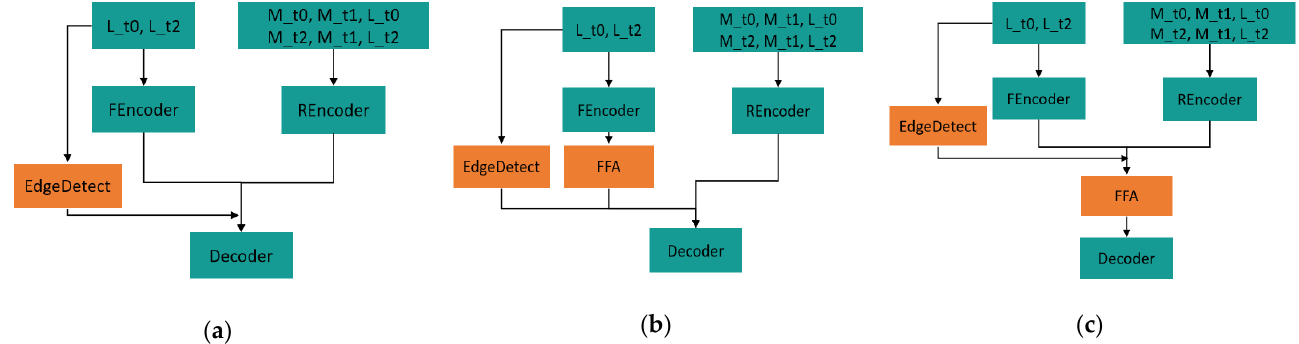
Figure 16. Network models used in the ablation experiment: ( a ) Only edge; ( b ) Edge-FA-encoder; and ( c ) Edge-FA-decoder.